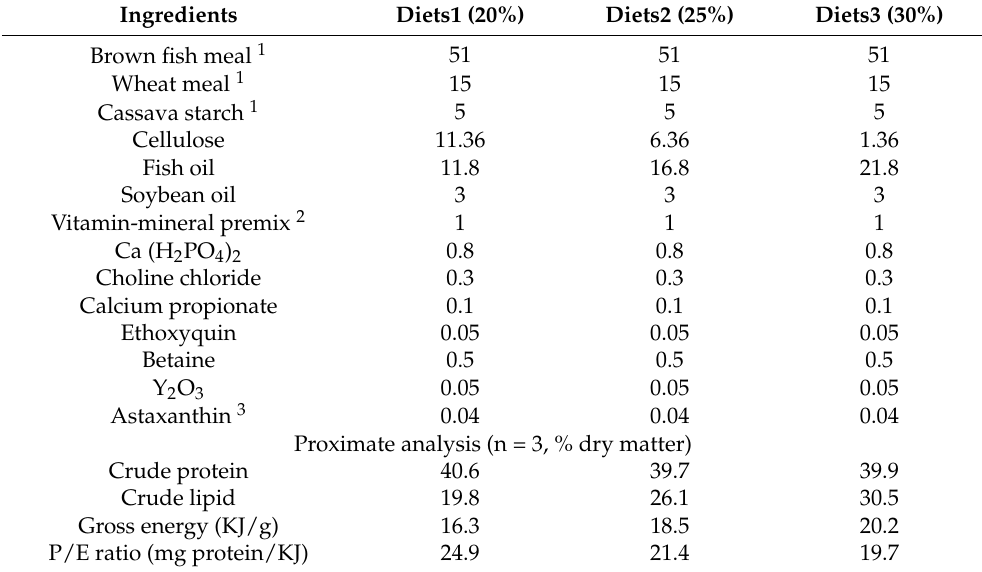
Table 1. Formulation and proximate compositions of the experimental diets (% dry